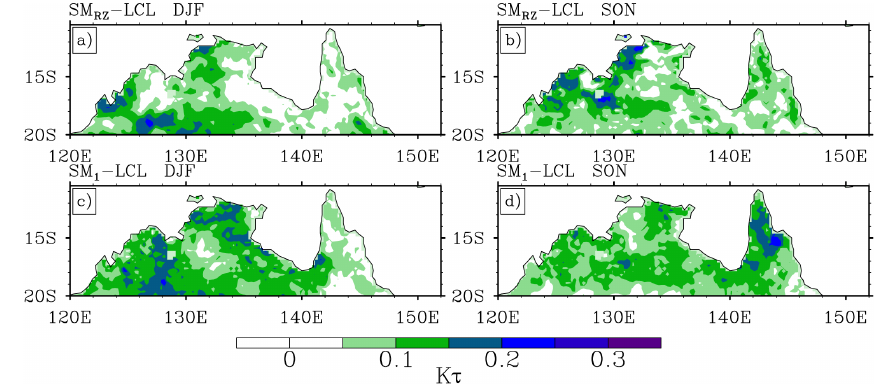
Figure 10. The standard deviation of the Kτ correlation metric among the ensemble members between the afternoon computed LCL and either the morning root zone soil moisture (SM rz ) over (a) DJF and (b) SON or the morning first layer soil moisture (SM 1 ) over (c) DJF and (d)